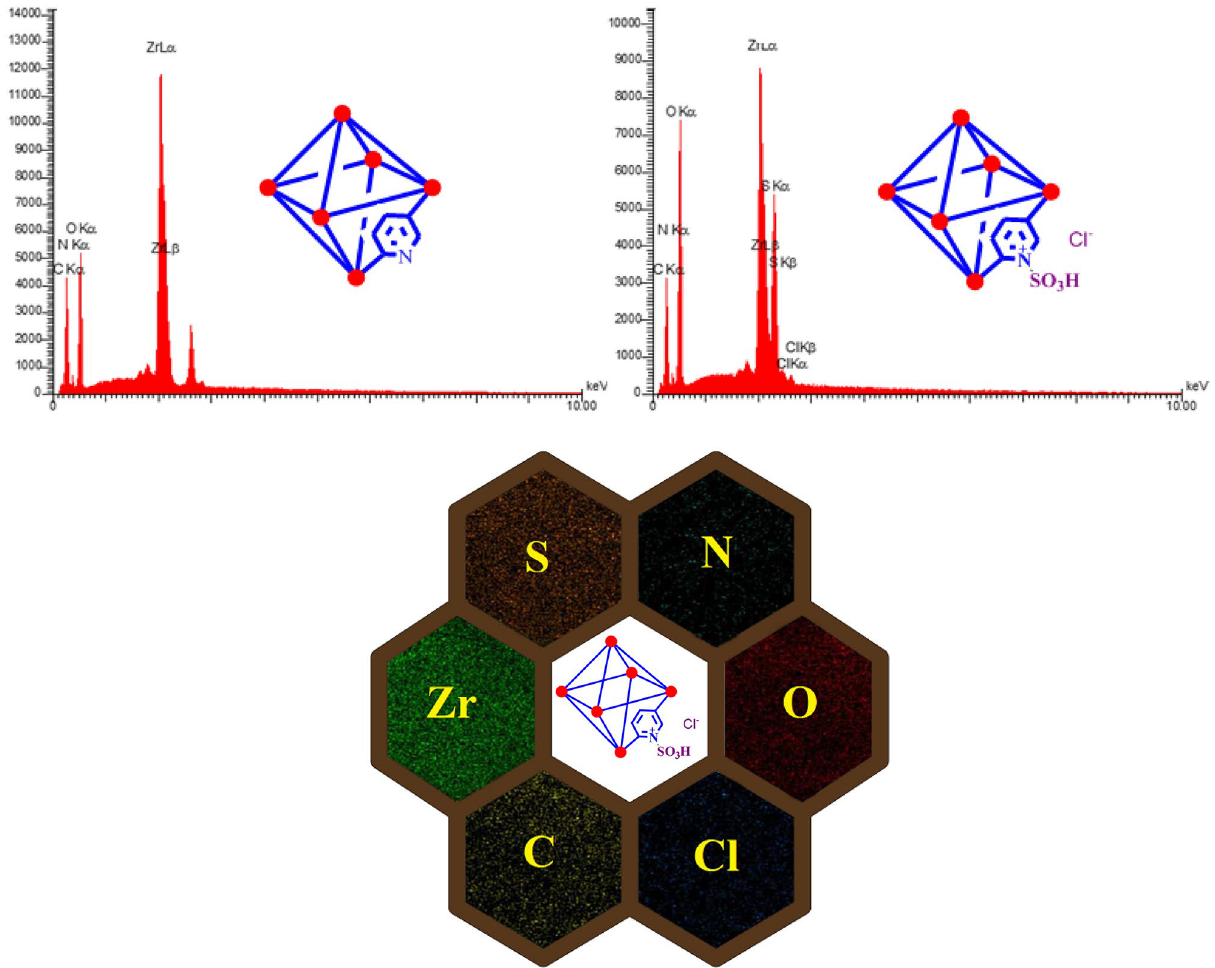
Figure 4. Up: Energy-dispersive X-ray spectroscopy (EDX) of [Zr-UiO-66-PDC-SO 3 H]Cl and Zr-UiO-66- PDC. Down: Elemental mapping analysis of [Zr-UiO-66-PDC-SO 3 H]Cl. The structures of the compounds were drawn using Chem Office 12.0 (Cambridge